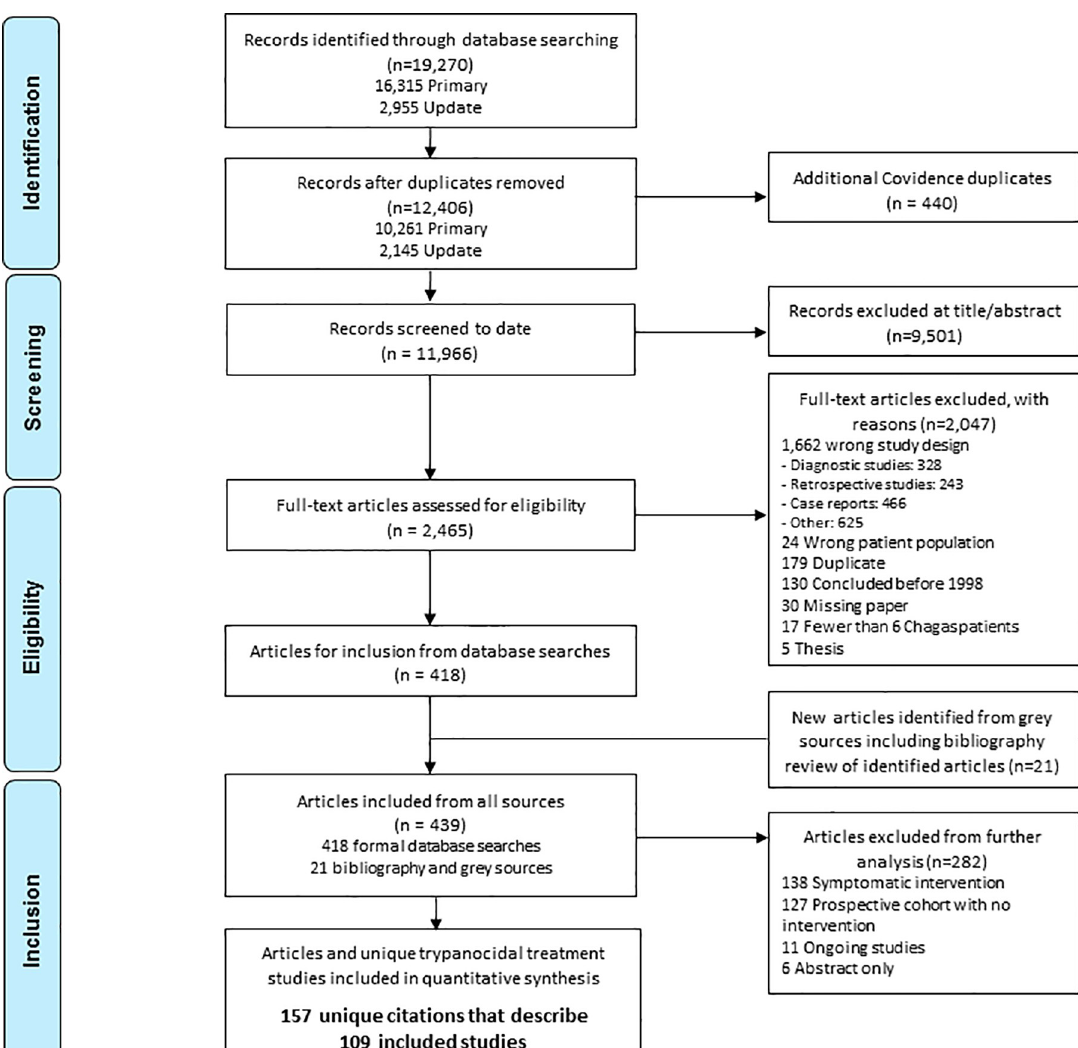
Fig 1. Preferred Reporting Items for Systematic Reviews and Meta-Analyses (PRISMA) flow diagram of publications